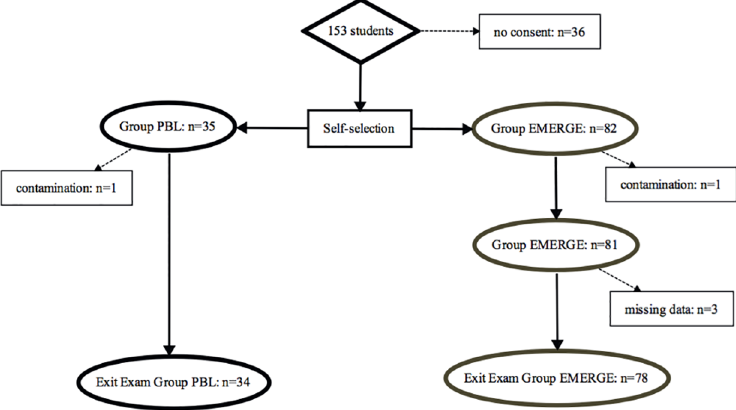
Fig 2. Flow of participants through the study. Contamination occurred when students attended another group´s teaching sessions and thereby were erroneously exposed to the wrong session at least once.